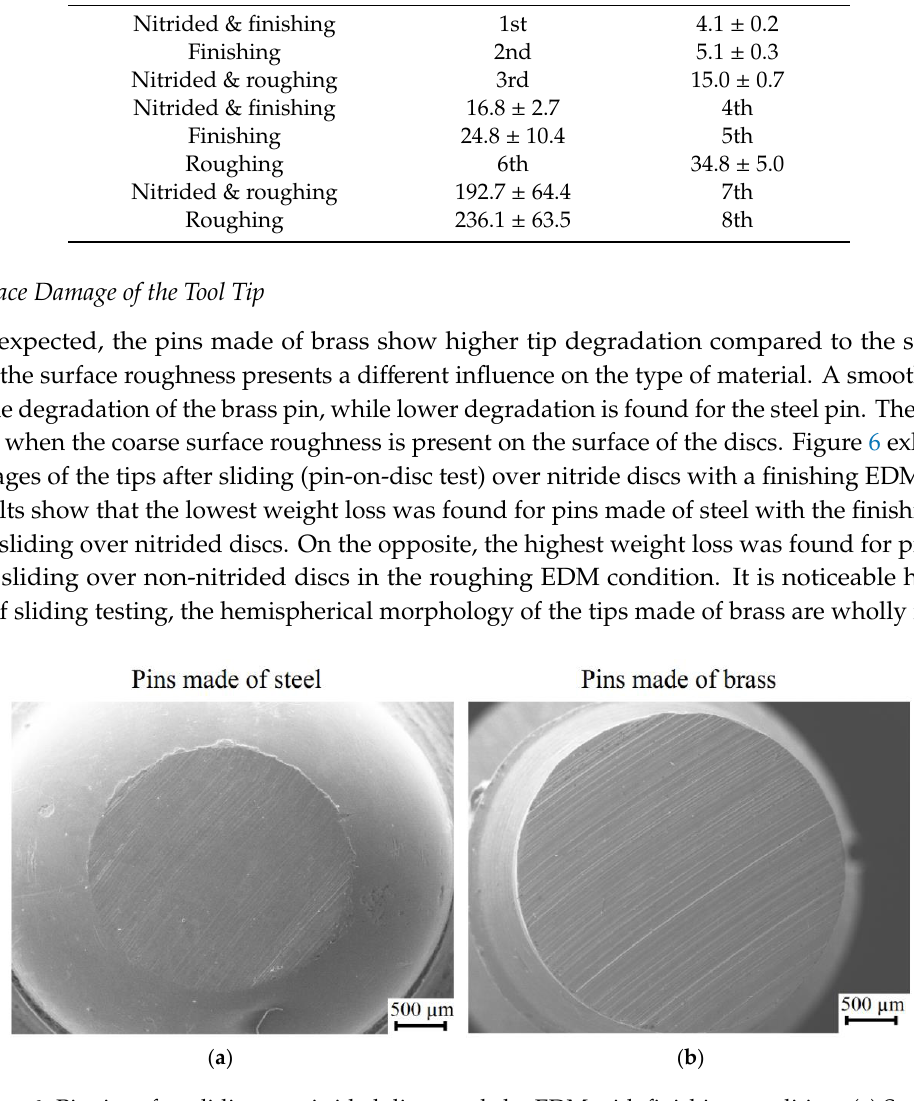
Figure 6. Pin tips after sliding on nitrided discs made by EDM with finishing condition. ( a ) Surface damage of a pin made of steel; ( b ) Surface damage of a pin made of brass.